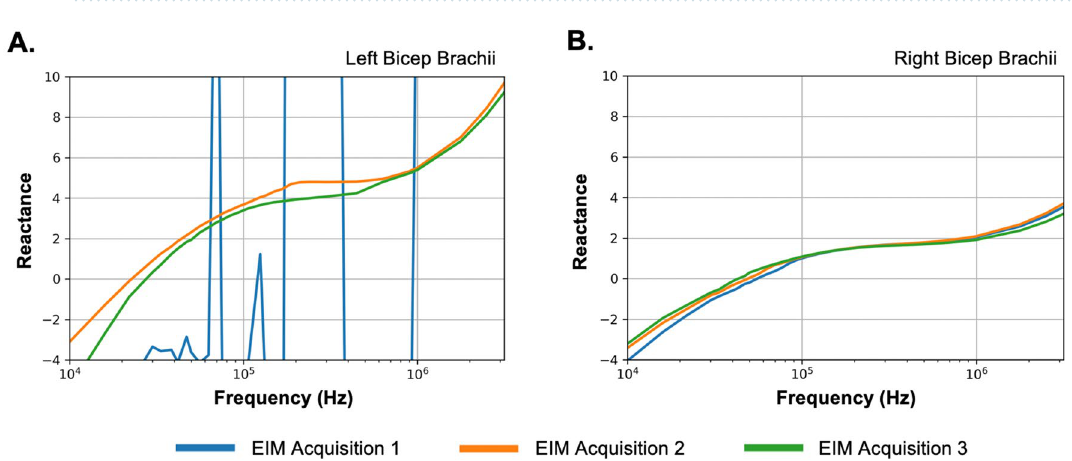
Figure 2. Real-time QA/QC of EIM data. ( A ) EIM traces from the left bicep brachii from FOP 003. In one EIM acquisition (blue trace) shows large spikes caused by accidental patient movement or movement of the EIM device by the care provider, warranting a rescan of the left bicep brachii. Subsequent scans of the left bicep brachii (green and orange traces) showed no artifact and were incorporated in data analysis. ( B ) Raw EIM traces from FOP 003 from the right bicep brachii. The EIM traces were collected during same study session and showed no signal